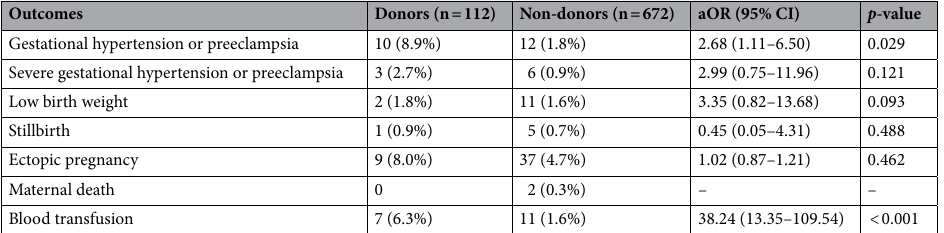
Table 2. Pregnancy outcomes between donors and matched non-donors. aOR adjusted odds ratio, 95% CI 95% confidence